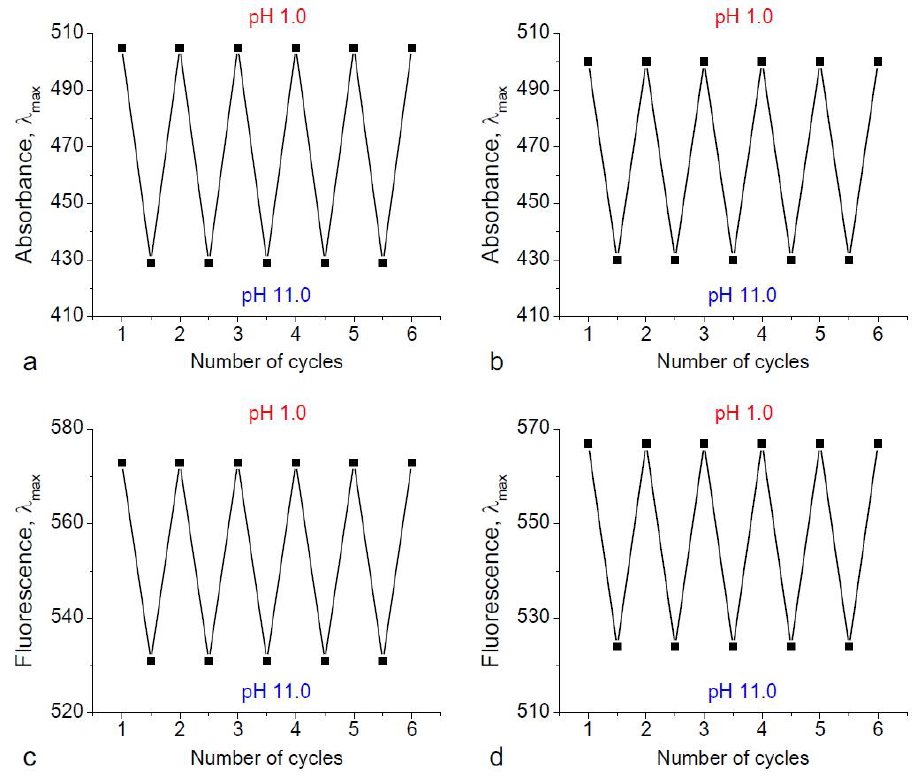
Figure 10. Changes of absorbance ( a , b ) and fluorescence ( c , d ) λ max during five consecutive measurements of pH = 1.0 and recycling of the indicator at pH = 11.0 in aqueous samples by 30-layer LB ( a , c ) and LS ( b , d ) films. The spectral data were recorded after immerging of the indicators during 30 s in the acidic and basic